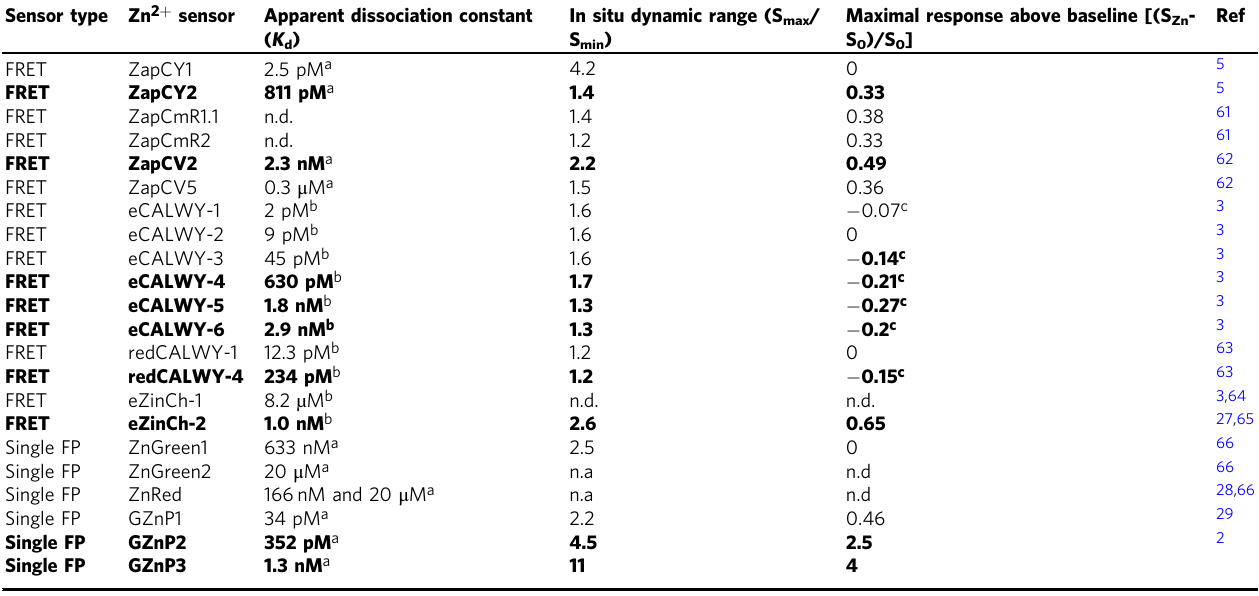
Table 1 Comparison of GZnP3 with previously published genetically encoded Zn 2 + sensors Sensor type Zn 2 + sensor